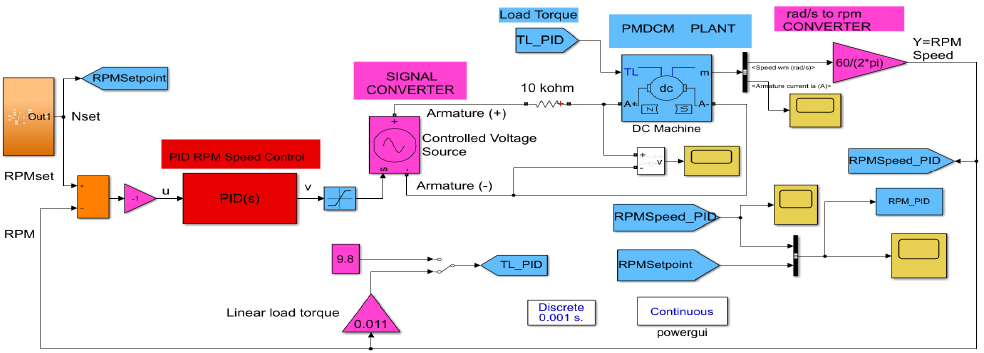
Figure 31. Closed-loop PMDCM-proportional-integral-derivative (PID) RPM speed control.